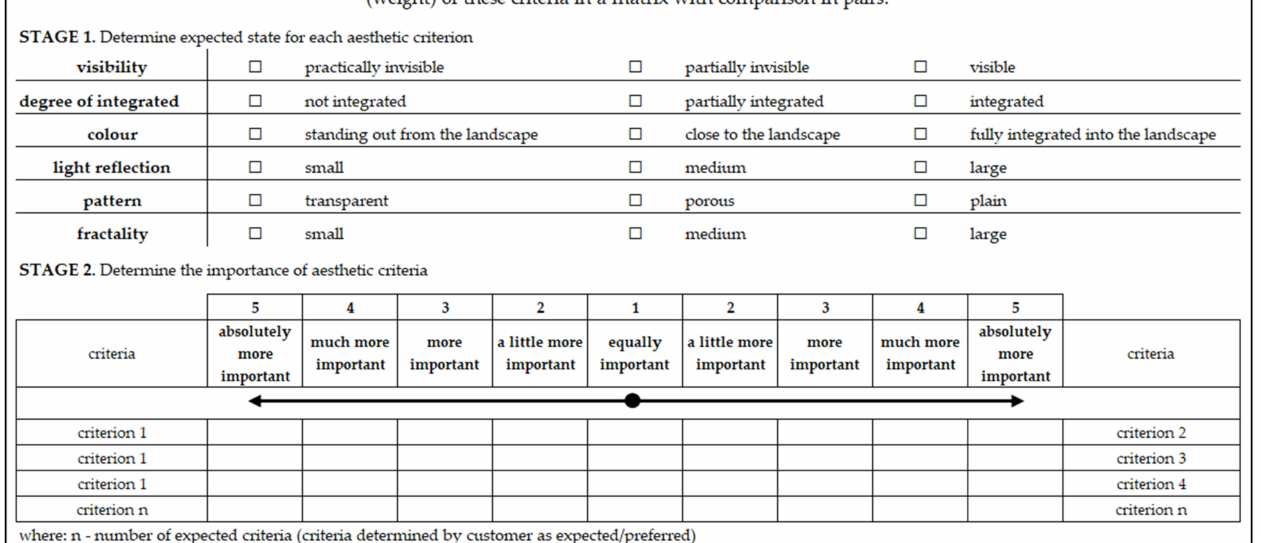
Figure 6. Example of questionnaire to obtain customer expectations about aesthetic criteria. Own